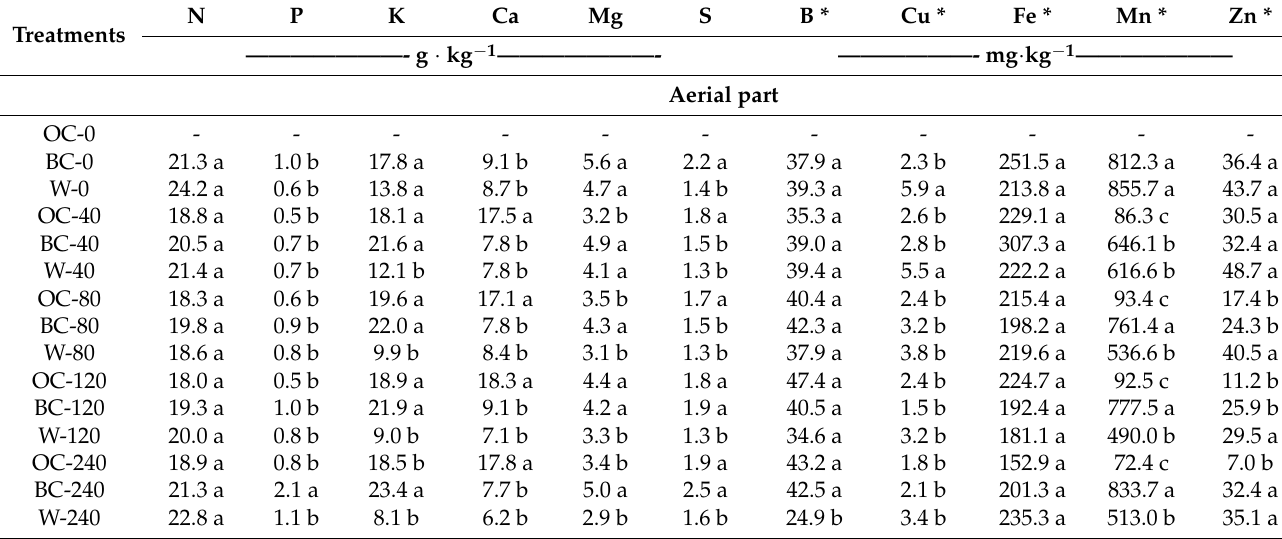
Figure 5. Principal component analysis of the macronutrient contents in the roots of D. apurensis as a function of P dose in waste without organic amendments (W), with biochar (BC), and with organic compost (OC). Table 3. Content of macronutrients and micronutrients in the aerial part and roots of D. apurensis as a function of doses of P without organic amendments (W) with biochar (BC) and with organic compost